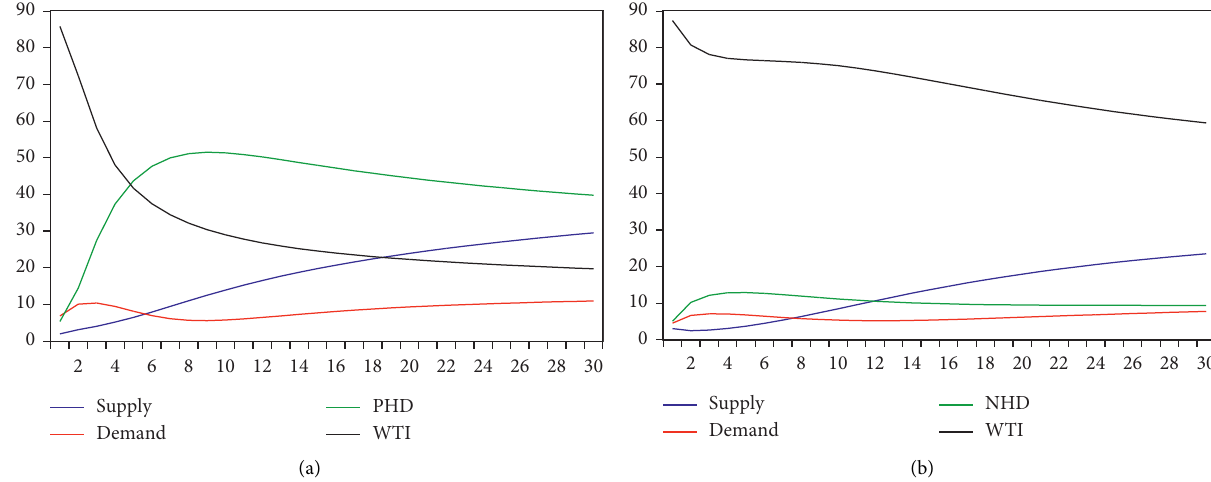
Figure 13: Results of variance decomposition of WTI oil prices. (a) Percent WTI oil prices variance due to PHD. (b) Percent WTI oil prices variance due to NHD.